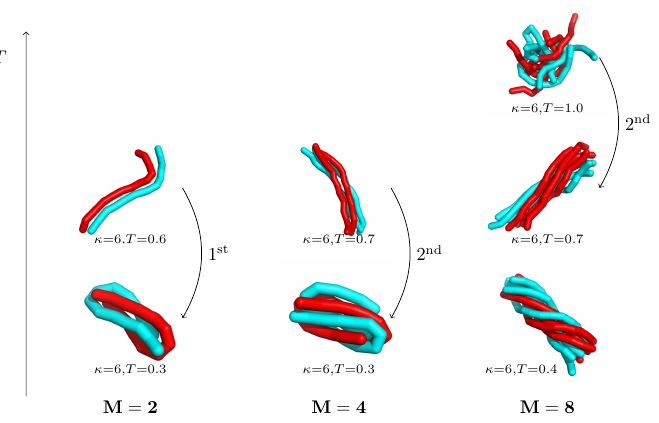
Figure 6. Size-dependence of the sub-aggregation re-ordering transitions within the aggregate for κ = 6. Representative conformations are presented in the intermediate-stiffness regime for M = { 2,4,8 } polymers of length N = 13. M = 2 polymers show a first-order-like bundle-to-hairpin structural transition [110], while the finite-size transition for M = 4 polymers from elongated bundles to bundled hairpins is second-order like. M = 8 polymers show a second-order-like amorphous-to-bundle transition followed by the formation of twisted bundles at even lower temperatures